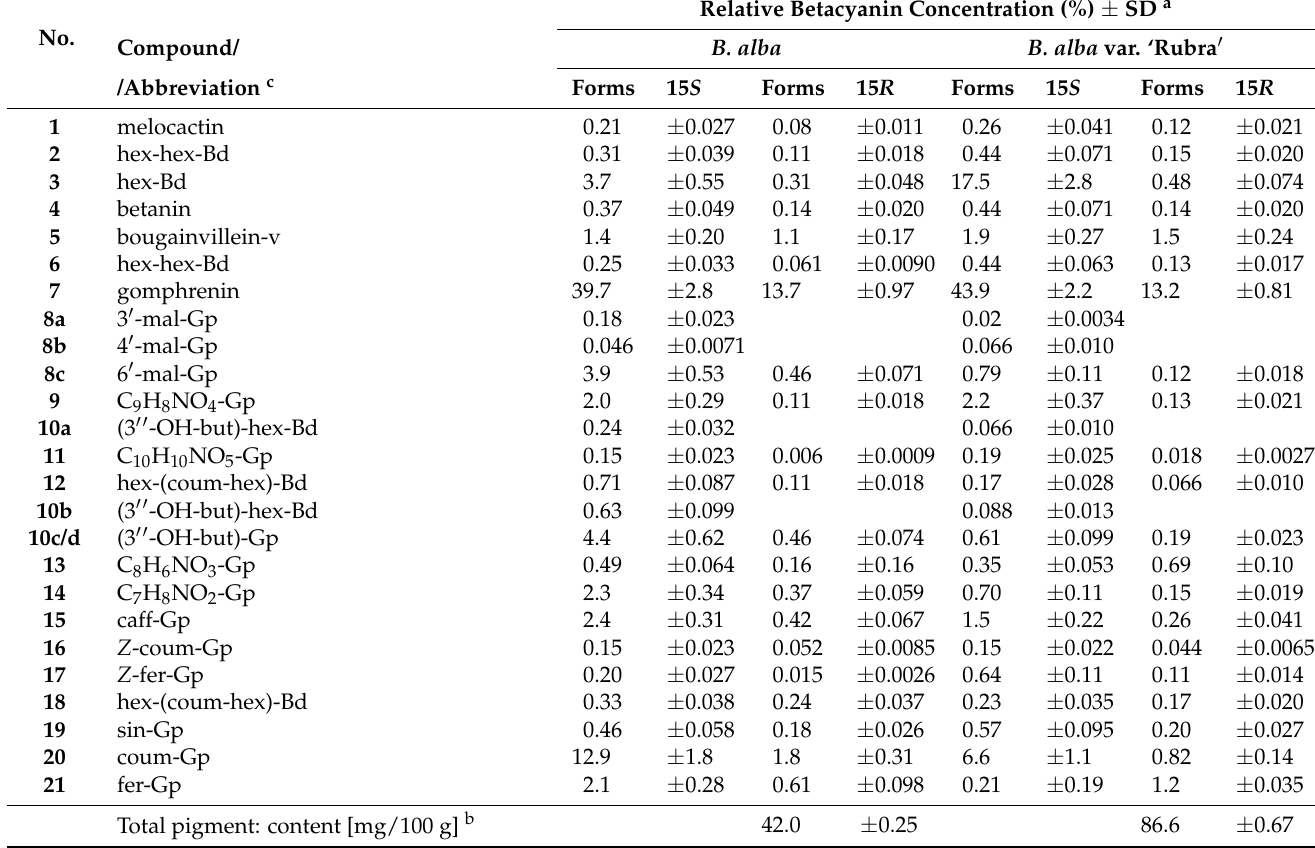
Table 5. Total contents and relative concentrations of betacyanins (15 S ) and their isoforms (15 R